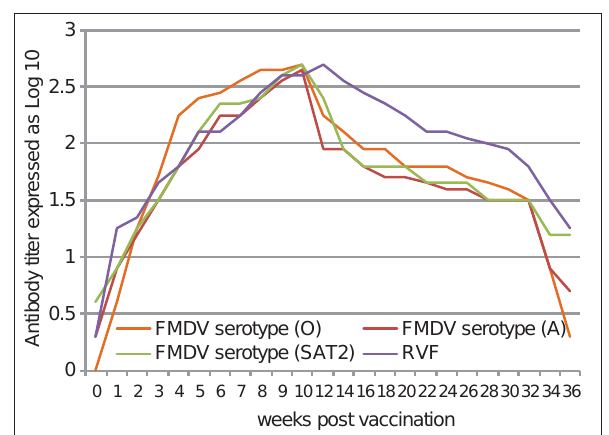
Figure-2: Mean Antibody titers in pregnant ewes vaccinated with combined Foot and Mouth disease/Rift Valley Fever vaccine estimated by serum neutralization test.